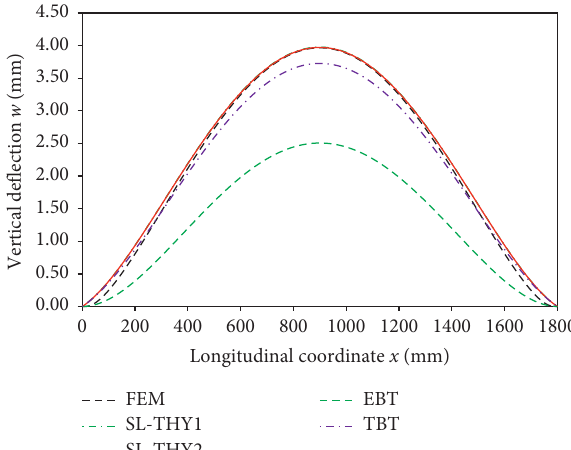
Figure 17: Comparison of vertical deflections predicted by the proposed methods (SL-THY1 and SL-THY2), EBT, TBT, and FEM analysis for the fixed-end box girder (example 4).